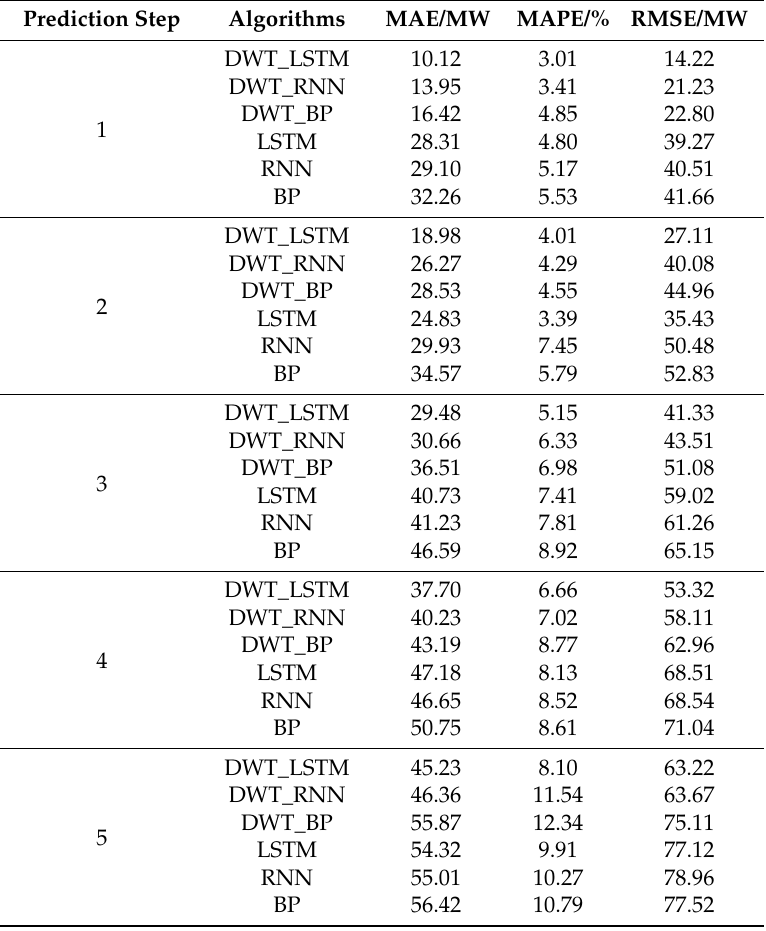
Table 1. Evaluation indexes of farm 1. RNN: recurrent neural network; BP: back-propagation; MAE: mean absolute error; RMSE: root mean square